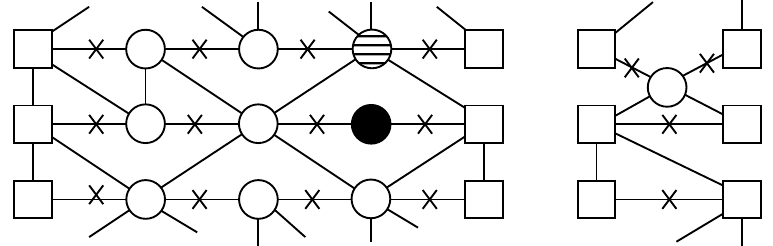
Figure 25 . On the left we have a combination of four tubes as in (4.4). Note that one of the nodes, denoted in black, has N f = N and therefore its dynamics leads to it being Higgsed and the groups connected to it identi(cid:12)ed. Following this, the node denoted with dashed lines becomes 2 N = N f . After performing Seiberg duality on this node, as well as a sequence of similar manipulations, we obtain the quiver on the right hand side. This is the same as the one obtained by closing punctures in [9] as in (cid:12)gure 24, if one (cid:13)ips the sign of one of the punctures as our tubes have punctures of di(cid:11)erent